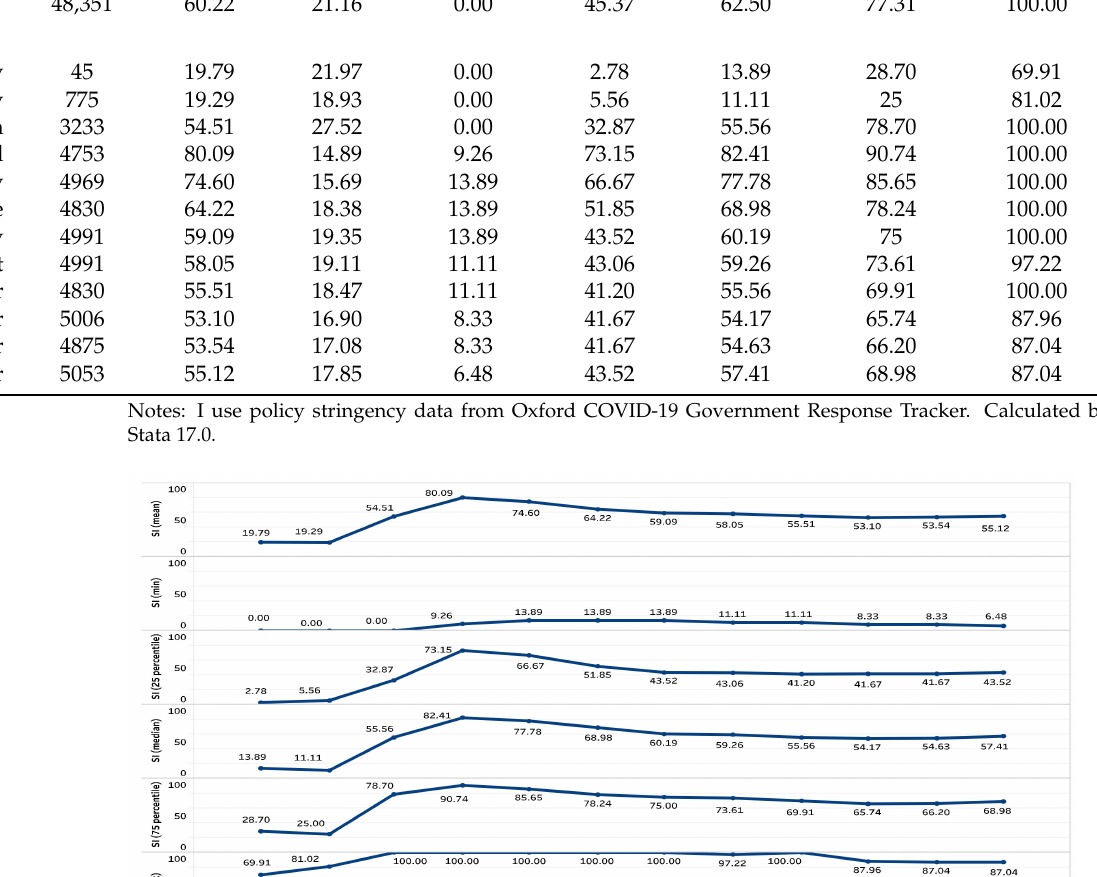
Table 2 confirms the significantly strong inter-correlations of six individual WGI dimen- sions. (The range of correlation is referred to in the article Correlation Coefficient: Simple Definition, Formula, Easy Steps. When the correlation coefficient is between 0.40 and 0.69, it means a strong positive relationship between the two variables, and the